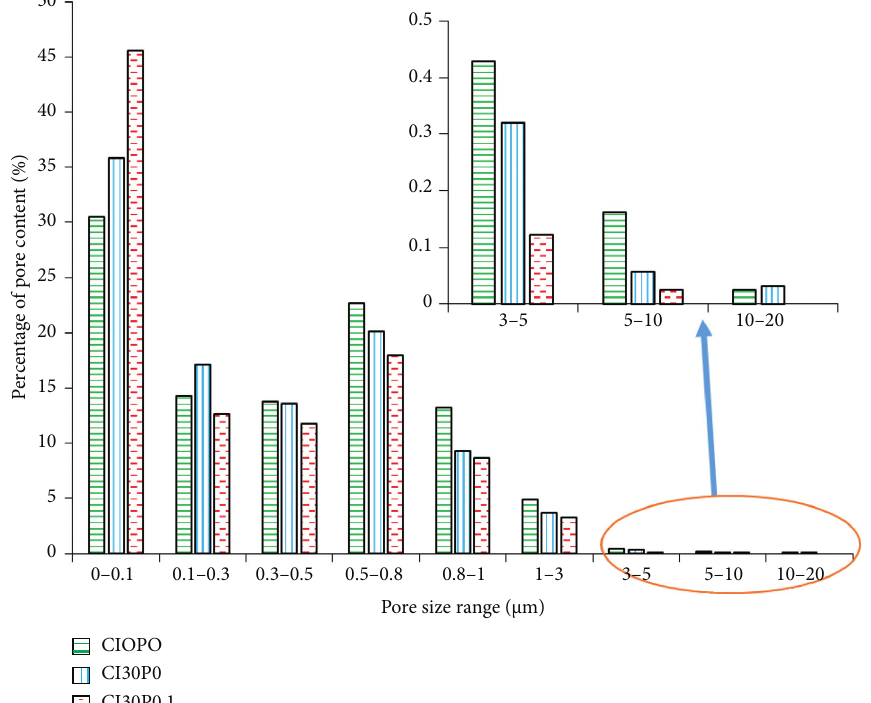
Figure 6: Pore size distribution of section 2 in CI0P0, CI30P0, and